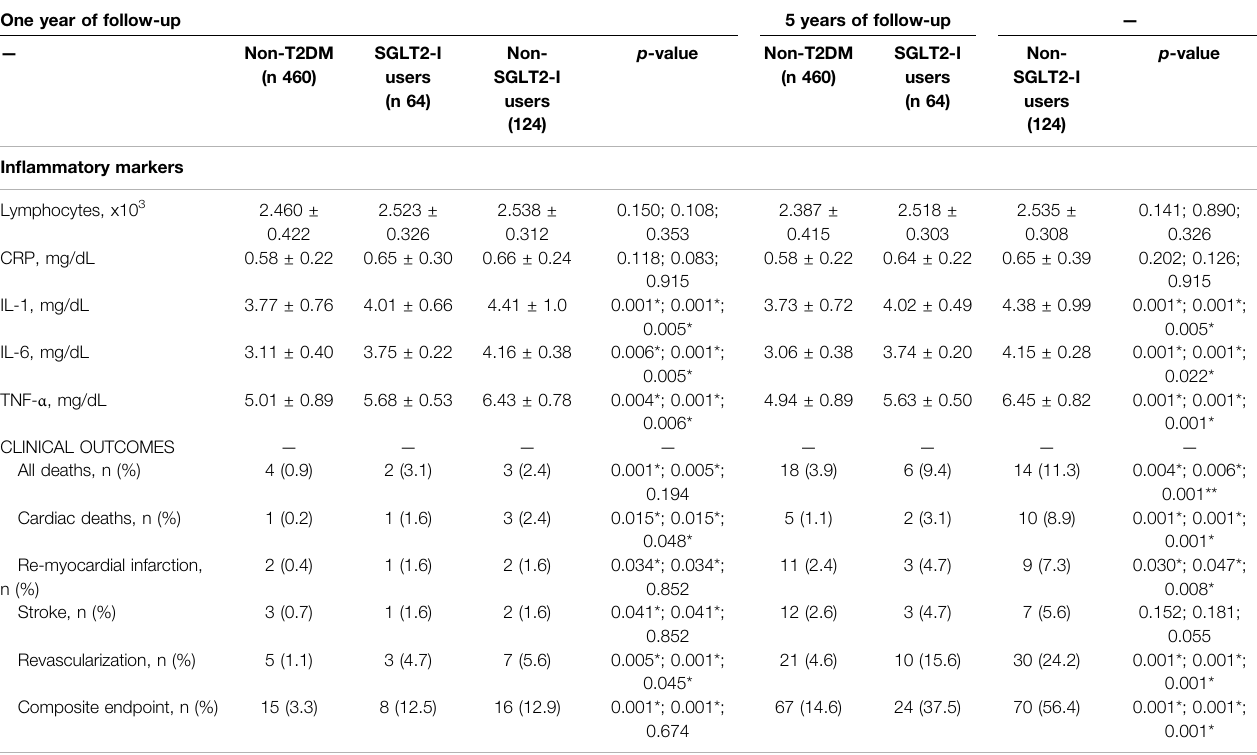
TABLE 2 | Study outcomes: in fl ammatory markers and clinical outcomes at 1, and 5 years of follow-up. One year of follow-up